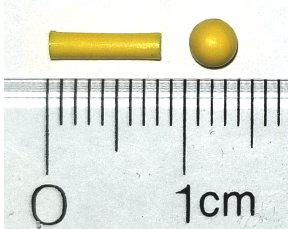
Figure 4. Spherical and cylindrical bead